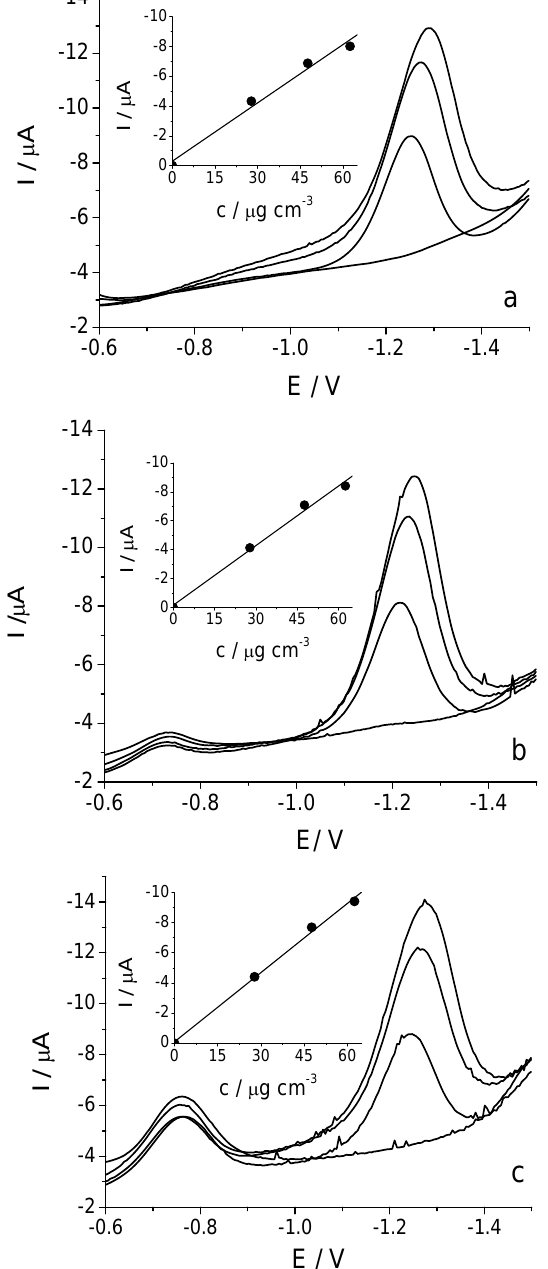
Figure 8. Differential pulse voltammograms recorded at TCP-CPE ( a ), Bi5-TCP-CPE ( b ) and Bi20-TCP-CPE ( c ) for the different concentrations of imidacloprid in Britton–Robinson buffer solution pH